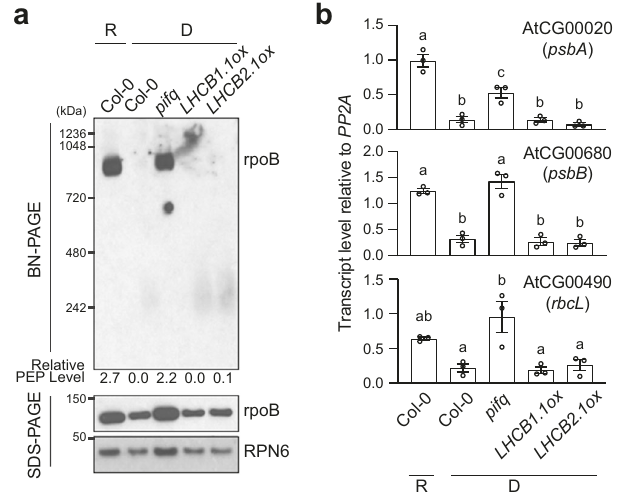
Fig. 4 | Ectopic expression of LHCB s does not activate the PEP. a Immunoblots showing the levels of the PEP complex, as well as its core component rpoB, in 4-d- old Col-0 seedlings grown in 10 μ molm − 2 sec − 1 R light and 4-d-old Col-0, pifq , LHCB1.1ox , and LHCB2.1ox seedlings grown in the dark. Total protein was isolated under either native or denaturing conditions and resolved via BN-PAGE or SDS- PAGEtoassessthefractionofrpoBinthePEPcomplexortheamountoftotalrpoB by immunoblots,respectively. Thenumbersbelow the immunoblotsrepresentthe relative PEP levels, whichwere calculated using the relativelevelof rpoBinthe PEP complex (BN-PAGE) divided by the relative level of denatured rpoB (SDS-PAGE) in each sample. b qRT-PCR analysis of the steady-state transcript levels of select PhAPGs, psbA , psbB ,and rbcL ,in4-d-oldCol-0seedlingsgrownin10 μ mol m − 2 sec − 1 R light and 4-d-old Col-0, pifq , LHCB1.1ox , and LHCB2.1ox seedlings grown in the dark. The transcript levels were calculated relative to those of PP2A . Error bars represent the s.e. of three biological replicates, and the centers of the error bars represent the mean values. Samples labeled with different letters exhibited statis- tically signi fi cant differences (ANOVA, Tukey ’ s HSD, P ≤ 0.05, n =3). The